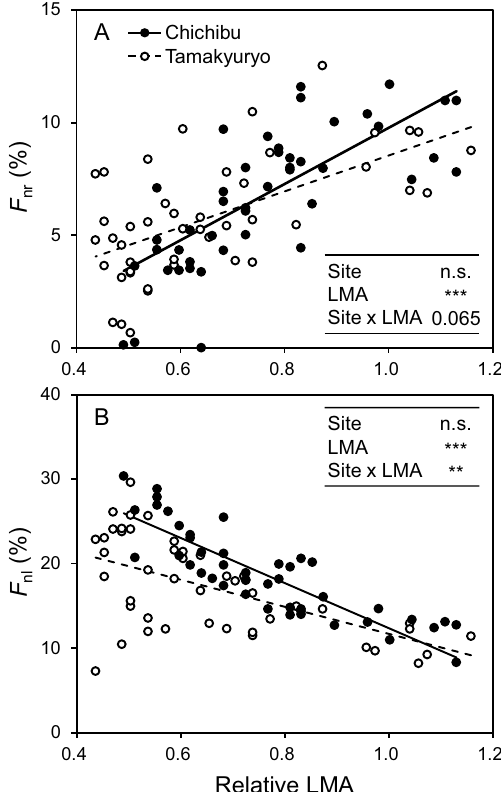
Figure 4. Fraction of leaf ( a ) nitrogen in Rubisco ( F nr ) and ( b ) light harvesting complex and photosystems ( F nl ) as a function of relative LMA of Q. serrata grown in FM Tamakyuryo (while circle) and FM Chichibu in 2018 (black circle) (n = 44). Dotted and solid lines indicate regression line of FM Tamakyuryo and FM Chichibu, respectively. Regression lines were drawn when the effect of relative LMA was significant. ** p < 0.01, *** p < 0.001, n.s., not significant. Actual p value is shown if 0.05 ≤ p <